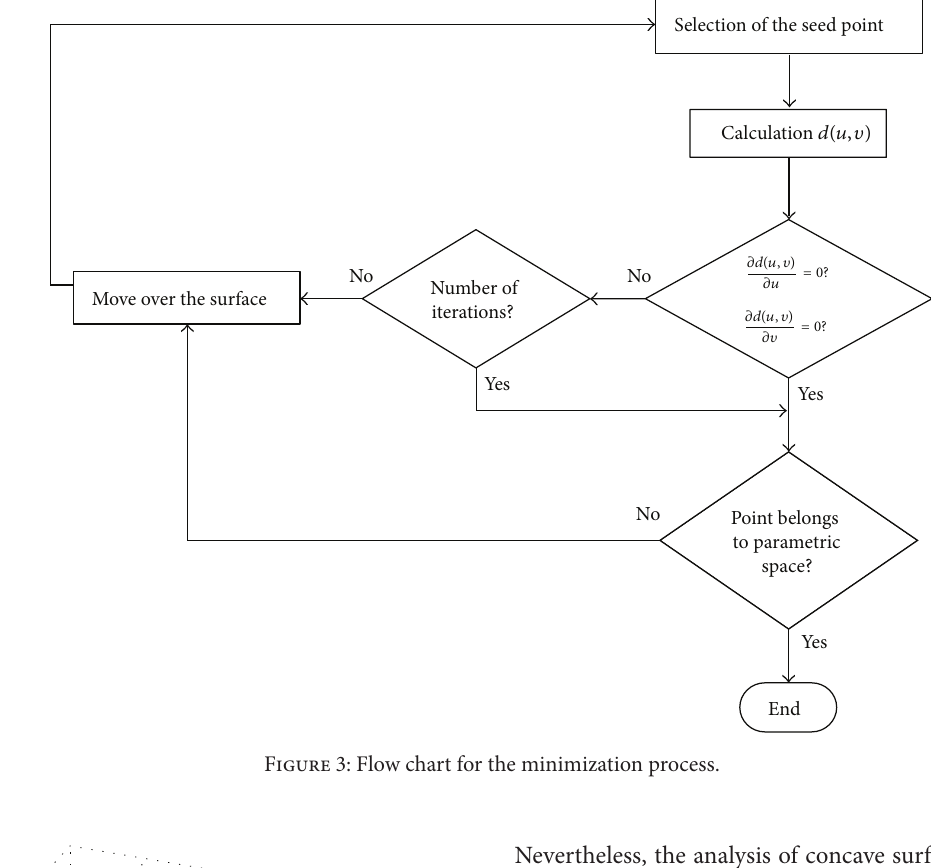
Figure 3: Flow chart for the minimization process.